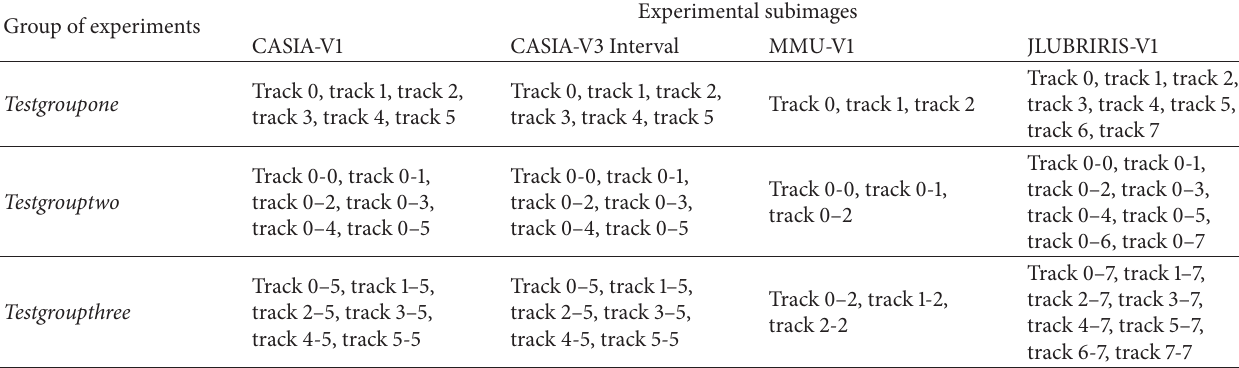
Table 4: Description of the three groups of